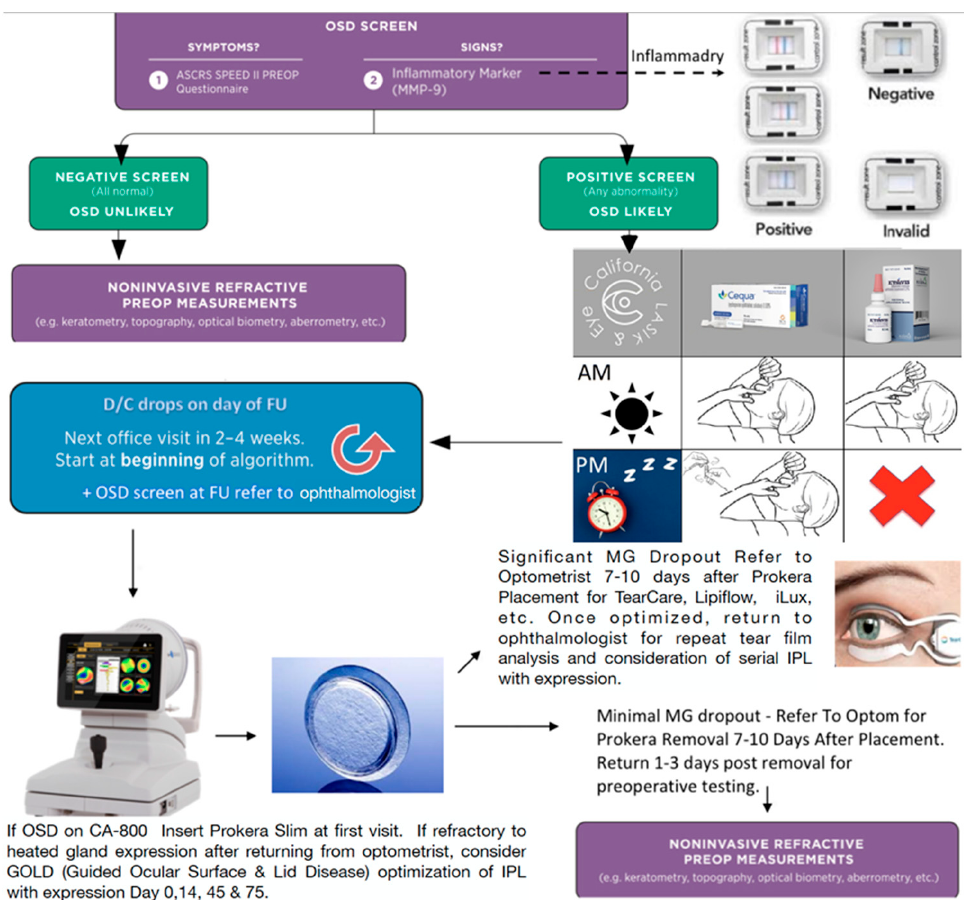
Figure 6. Guided Ocular Surface & Lid Disease (GOLD) Co-management algorithm. Incorporating aspects of the ASCRS algorithm one proposed GOLD co-management protocol involves first probing for signs with inflammatory for MMP-9 measurement (relatively low cost and placeable in every optometric office with a CLIA waiver). Symptoms can be established as well with SPEED II. Once